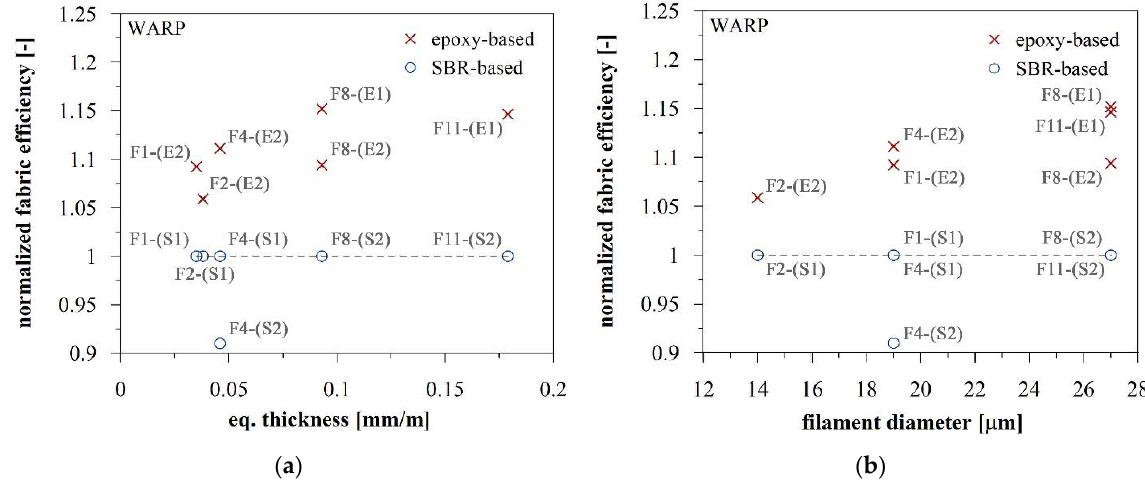
Figure 7. Normalized fabric efficiency vs. equivalent diameter ( a ) and filament diameters ( b ) in the warp direction.